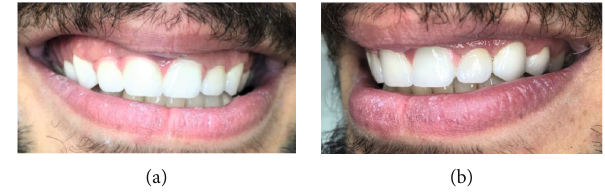
Figure 6: Posttreatment photograph with fi nal